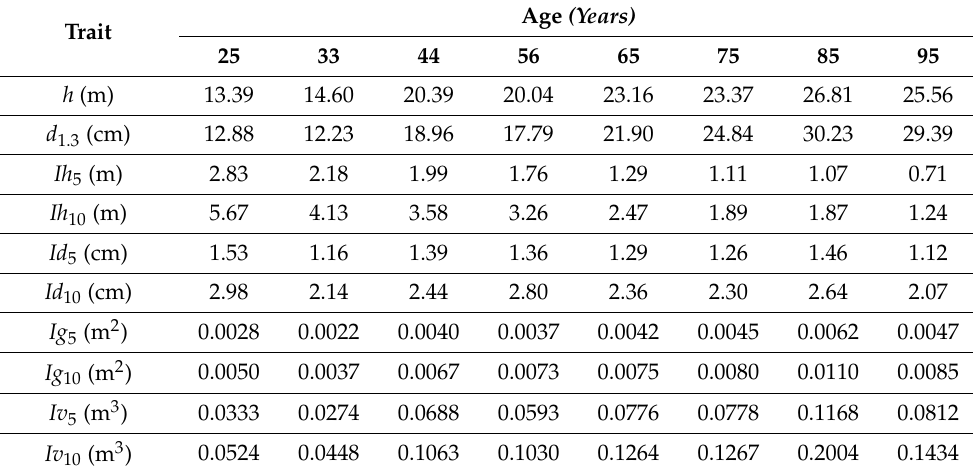
Table 2. Arithmetic means for dendrometric and increment